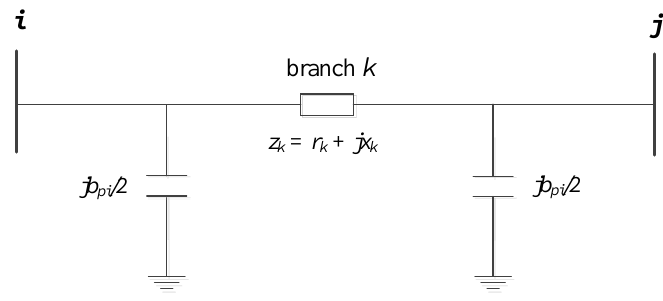
Figure 1. Single-line diagram of a 2-terminal circuit.